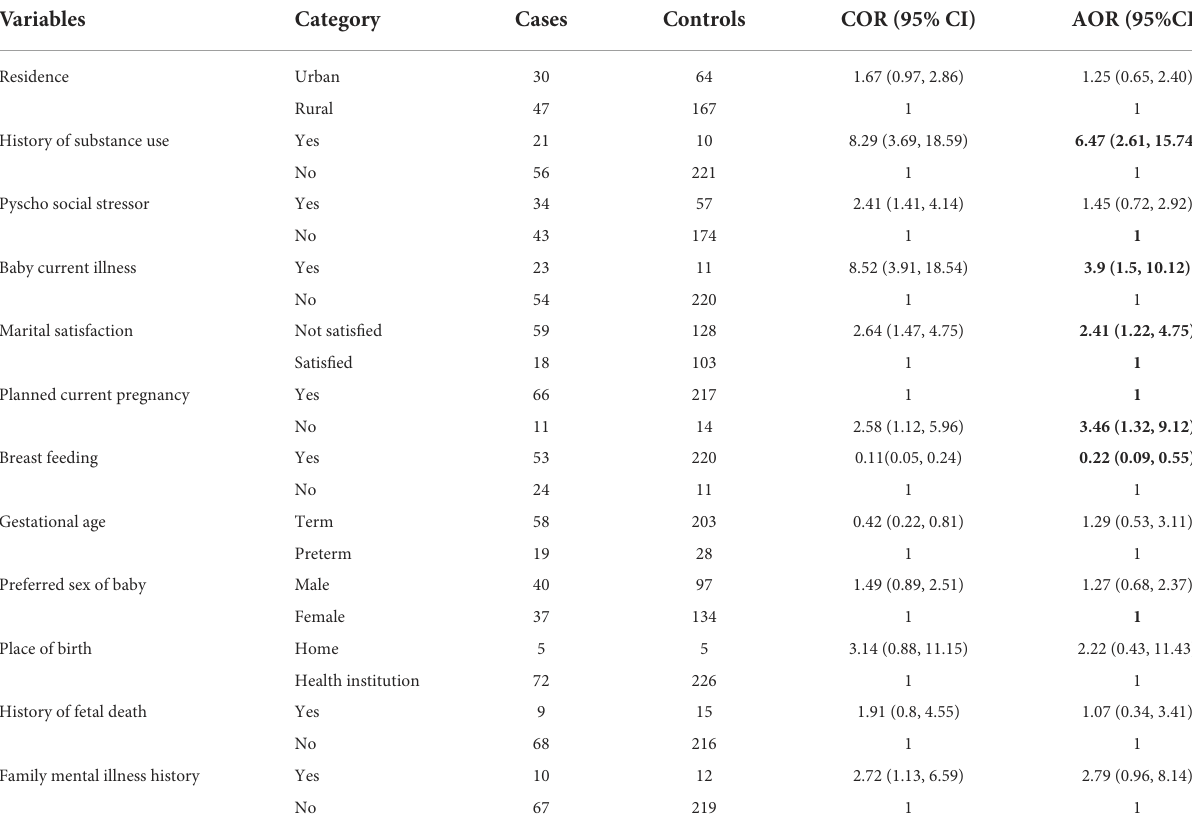
TABLE 5 Multivariable analysis on determinants of postpartum depression among postpartum mothers in Debre Tabor Town.